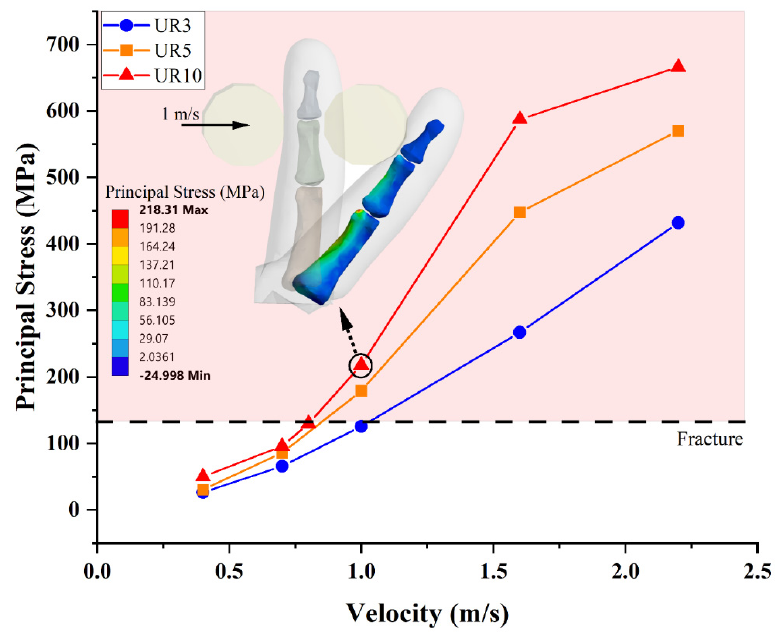
Figure 11. Abduction: Maximum Principal Stress.